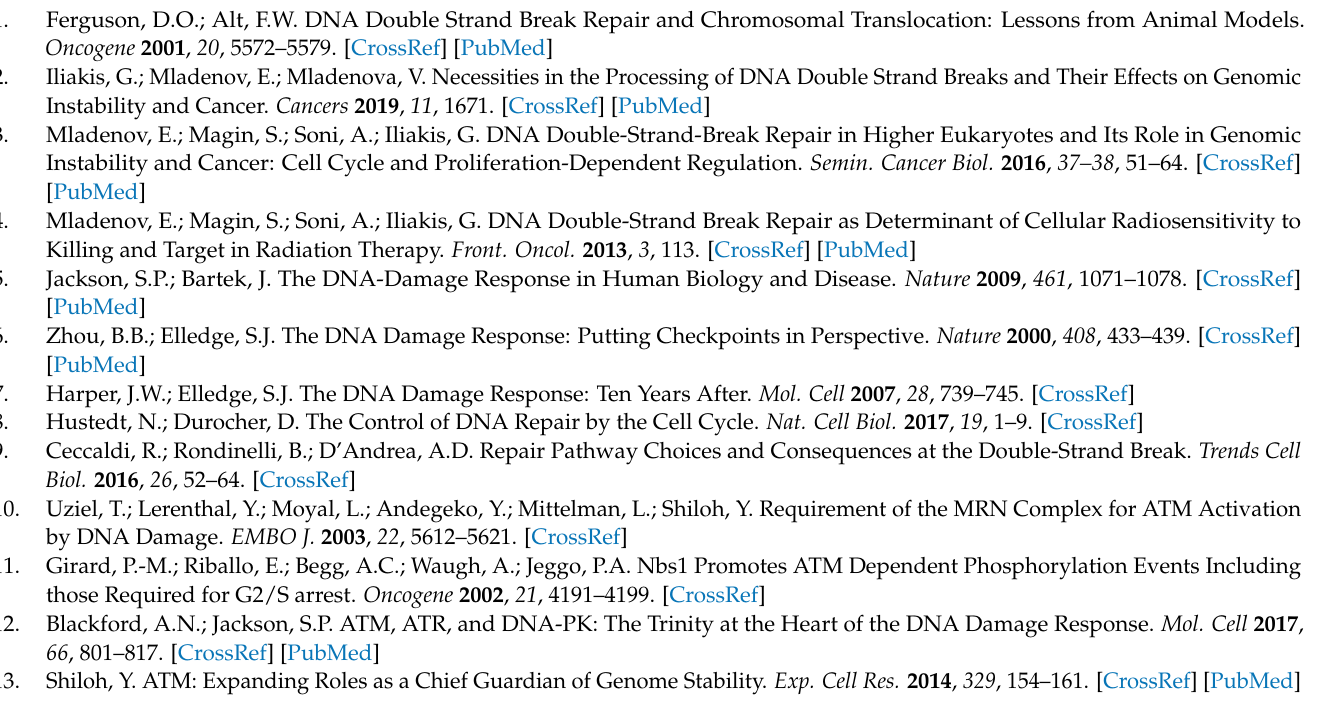
treated with DNA-PKcsi as indicated. (b) As in a for cells treated with combinations of ATMi and DNA-PKcsi as indicated. (c) As in b for cells treated with combinations of ATRi and DNA-PKcsi inhibitors as indicated. (d) As in c for cells treated with combined ATMi, ATRi and DNA-PKcsi; Figure S5: Validation of A549 cell cultures for the analysis of IR-induced G 1 -checkpoint in cells irradiated in G 0 ; Figure S6: IR-induced G 1 checkpoint in G 0 irradiated A549 cells; Figure S7: As in Figure 5 for A549 cells. Broken and solid lines show results without data points from Figure S6 or S7b; Data points are omitted to avoid congestion; Figure S8: (a–d) As in Figure S4 for A549 cells, (e) Example of the approach used to quantitate DNA-end-resection at DSBs by measuring RPA70 intensity in G 1 -phase of cells; Table S1: Statistical analyses of Figure 1; Table S2: Statistical analyses of Figure 3; Table S3: Statistical analyses of Figure 4; Table S4: Statistical analyses of Figure 5; Table S5: Statistical analyses of Figure 6b; Table S6: Statistical analyses of Figure S1; Table S7: Statistical analyses of Figure S2; Table S8: Statistical analyses of Figure S4; Table S9: Statistical analyses of Figure S6; Table S10: Statistical analyses of Figure S7; Table S11: Statistical analyses of Figure